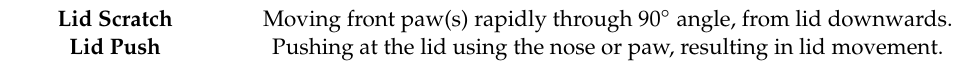
Table 1. Definitions of escape behaviors monitored (after [1]).